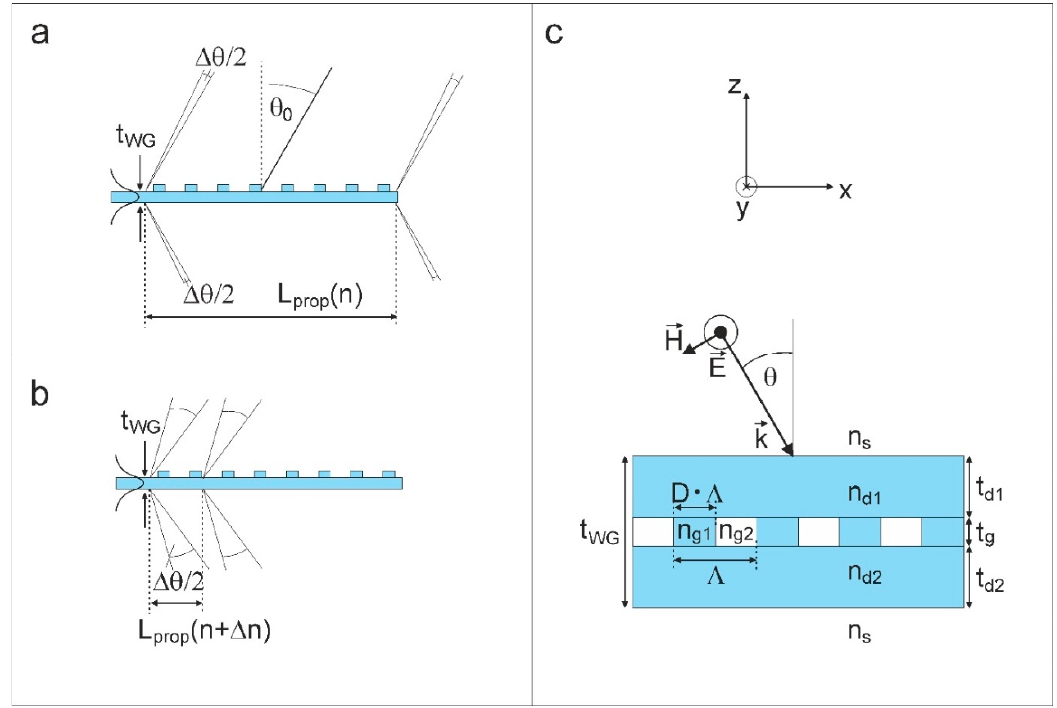
Figure 1. ( a ) A waveguide grating with an eigenmode of large propagation length L prop and, thus, a small angular divergence ∆ θ . θ 0 is the mean angle under which light is emitted; ( b ) a shorter propagation length L prop and larger ∆ θ under refractive index tuning ( n → n + ∆ n ); ( c ) the definition of the geometry parameters of the proposed waveguide grating. TE-polarized light is considered. Further details are provided in the text.